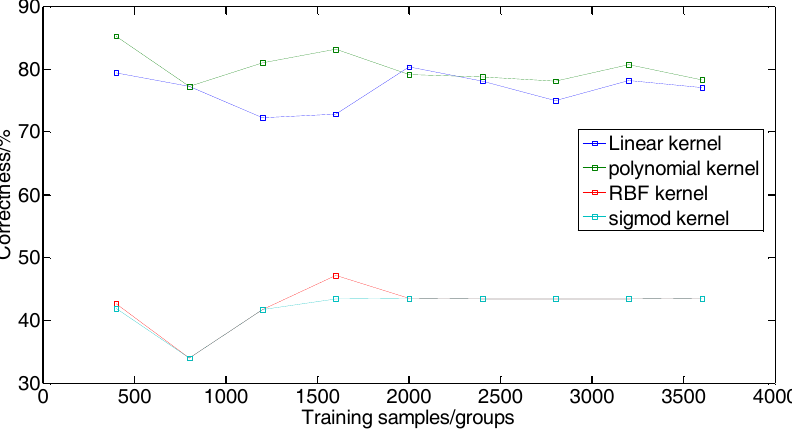
Figure 6. The correctness of four kernel functions.